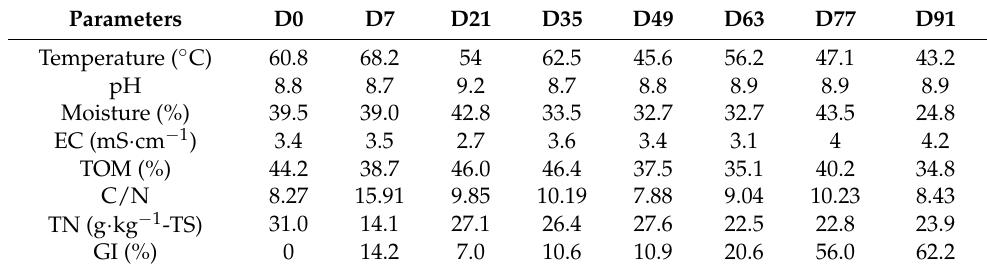
Table 2. Main physicochemical properties of compost samples during composting process.